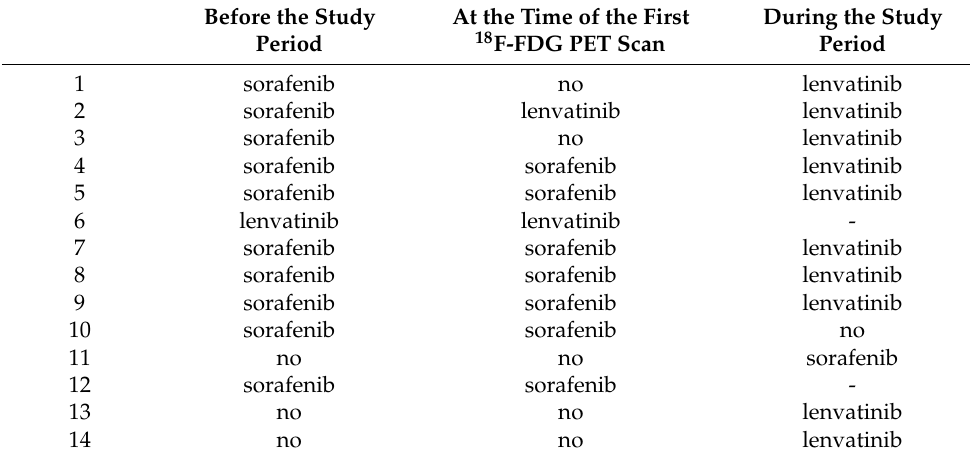
Table 2. The distribution of TKIs therapies among the study population and with regards to the study period.